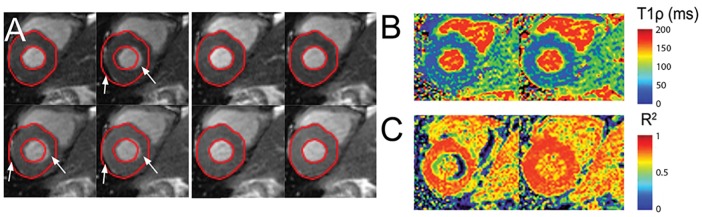
Motion correction of a T1ρ dataset in the large motion category.A, Top: Original images showing large motion. Bottom: Results of motion correction by applying optical flow registration. B, T1ρ maps before (left) and after (right) motion correction. C, R2 maps before (left) and after (right) motion correction.